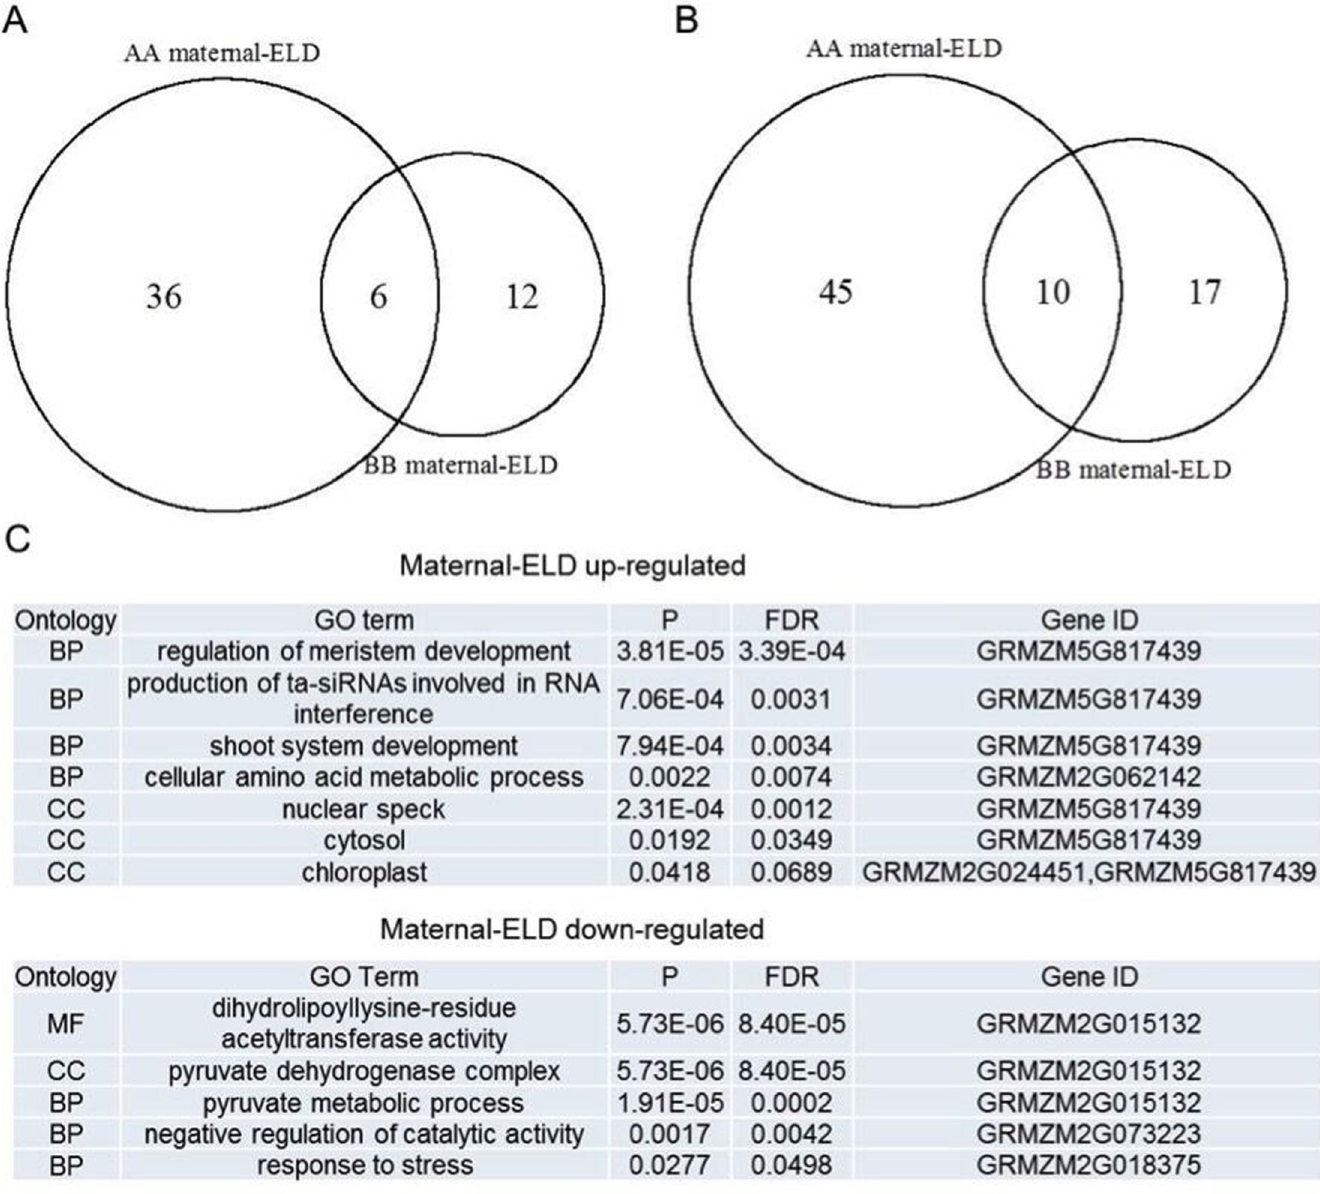
Fig 4. Venn diagram analysis of maternal expression-level dominance (maternal-ELD) genes in Zhengdan958 (A) and Anyu5 (B), and GO enrichment analysis of common maternal-ELD genes between the two hybrids (C). AA and BB denote Zheng58 and Ye478, respectively. BP: biological process; CC: cell component; MF: molecular